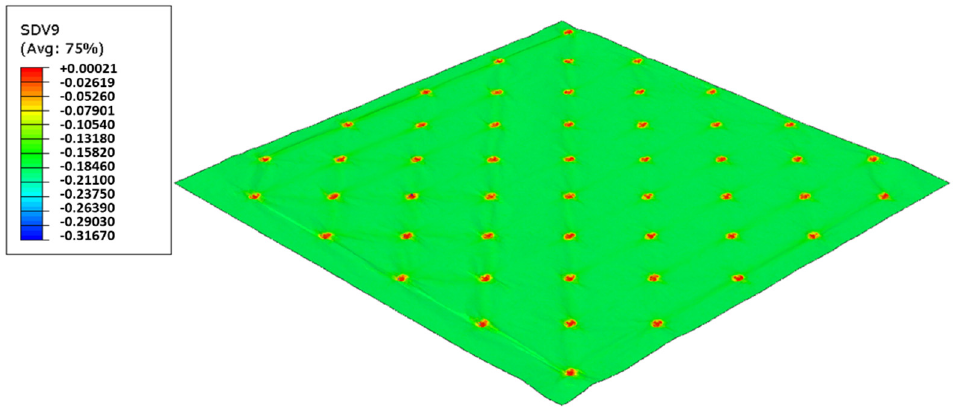
Figure 29. Micro die 48_75 Sh-A (NR BG/CR PR), Plastic field.